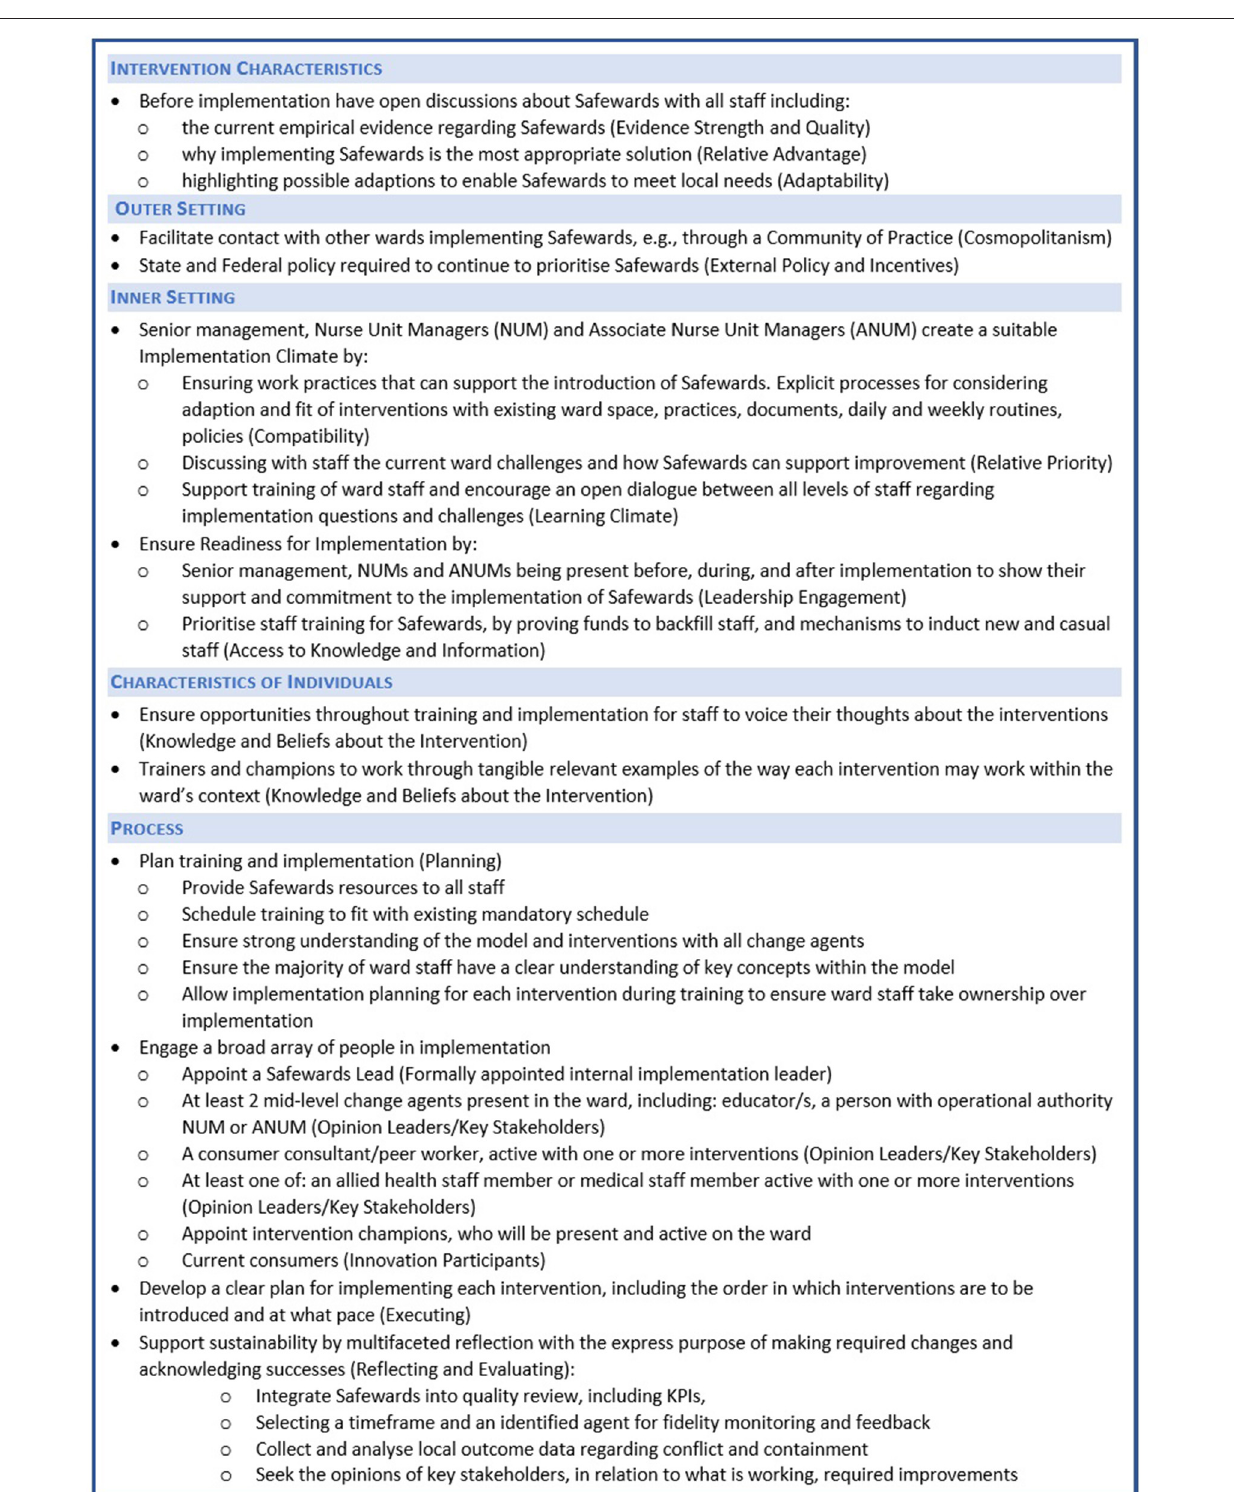
Frontiers in Psychiatry |